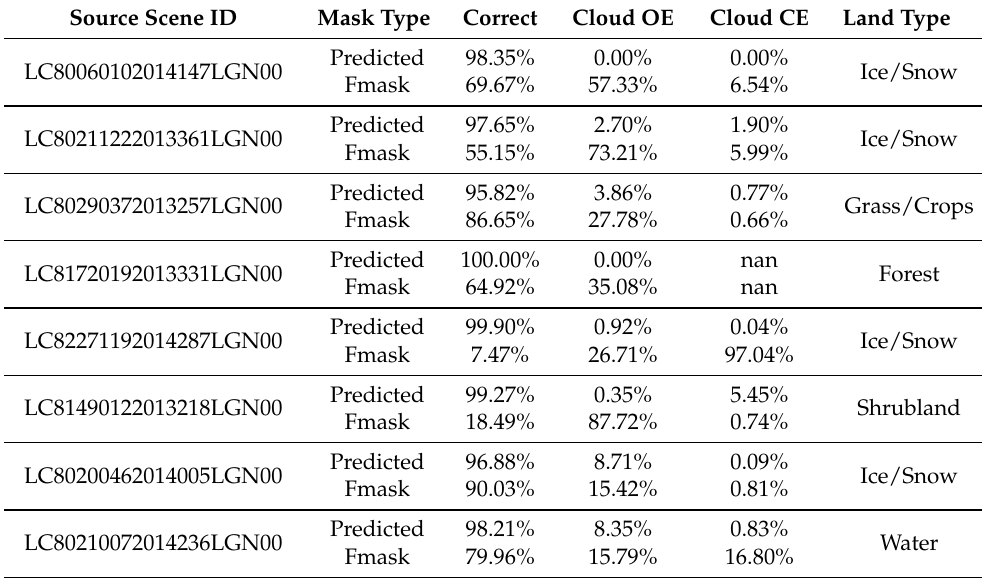
Table 7. Model predicted mask and Fmask accuracy comparison for low Fmask accuracy